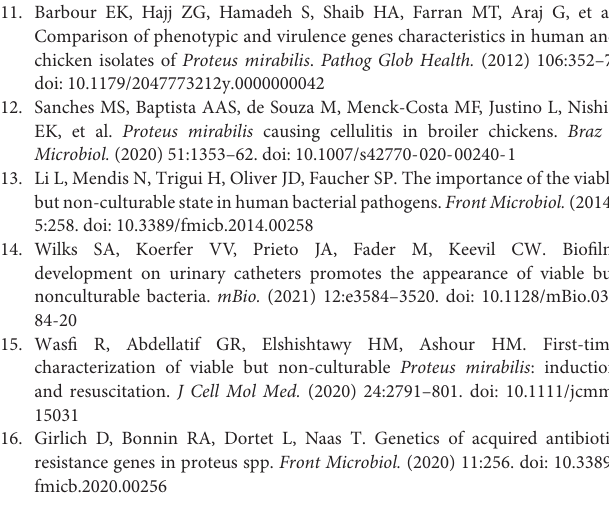
Supplementary Figure 1 | Data of therapeutic